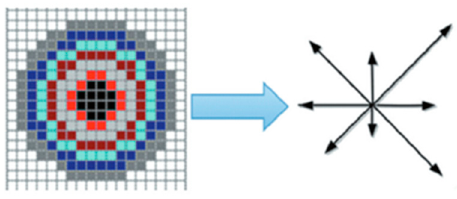
Figure 2. Feature description area.